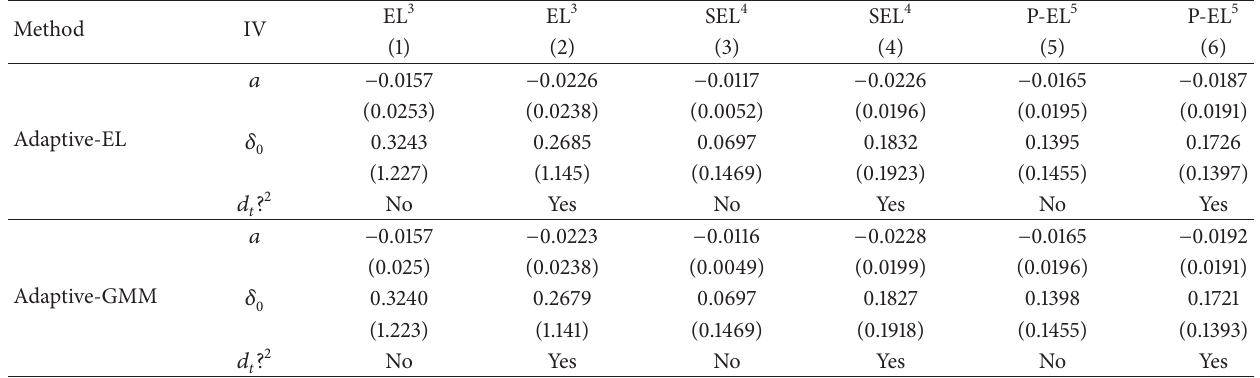
Table 4: EL and GMM shrinkage estimation of the labor supply equation 1